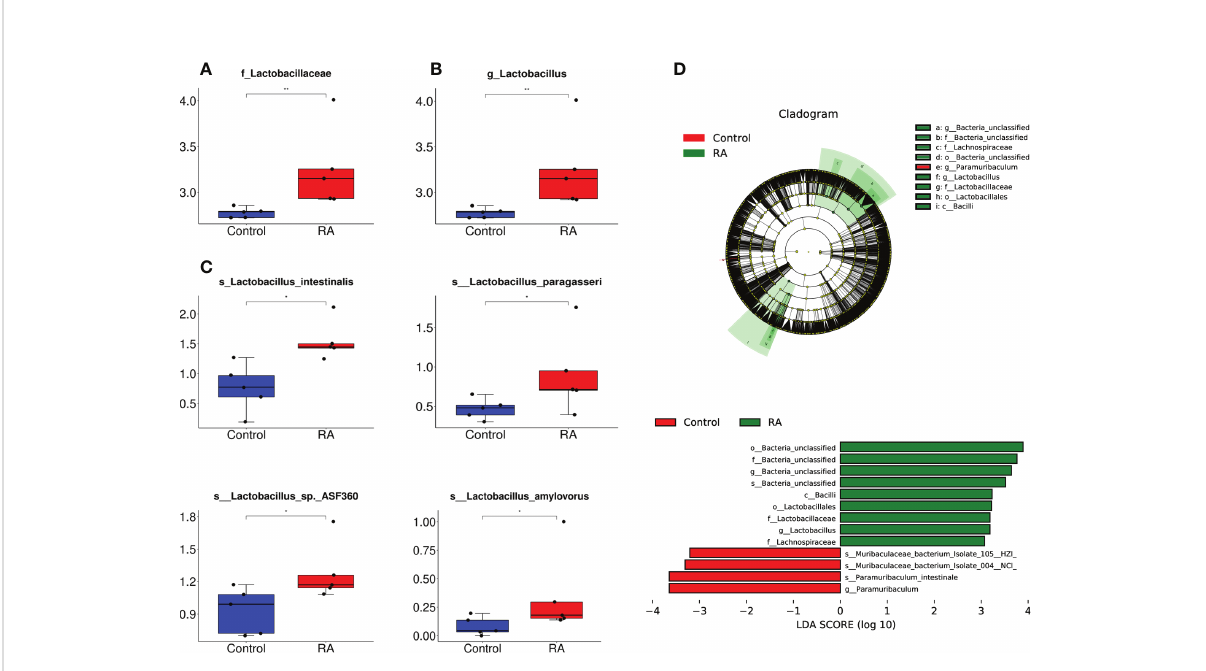
FIGURE 4 The relative abundance of microbial taxa at the family, genus, and species levels. (A, B) The relative abundance of Lactobacillales and Lactobacillaceae enriched in RA vs control at different levels. (A) , at family level; (B) , at genus level. (C) The relative abundance of Lactobacillus intestinalis , Lactobacillus paragasseri , Lactobacillus sp. ASF360 and Lactobacillus amylovorus enriched in RA vs . control. The box represents the interquartile ranges, inner line denotes the median. (D) The differences in abundance between the RA and control group by LEfSe analysis. o, order; f, family; g, genus; s, specie. * p < 0.05, ** p < 0.01 compared with control